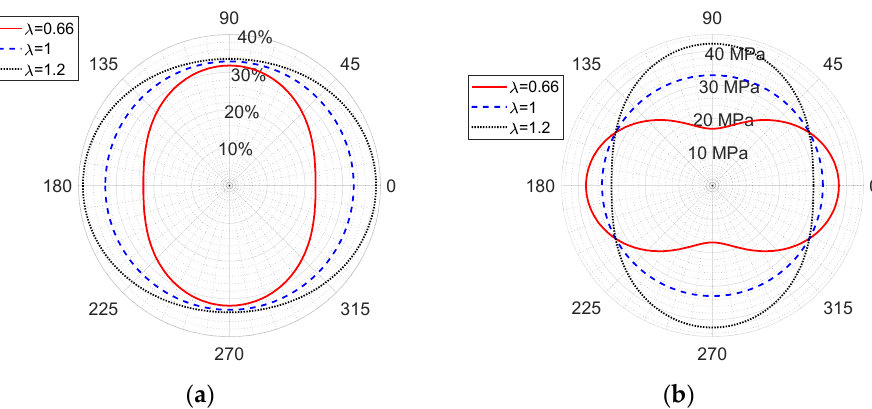
Figure 2. Distribution of volumetric strains at the intrados of the outer flexible liner ( a ) volumetric strain and of equivalent stress at the intrados of the concrete liner ( b ) equivalent stress.